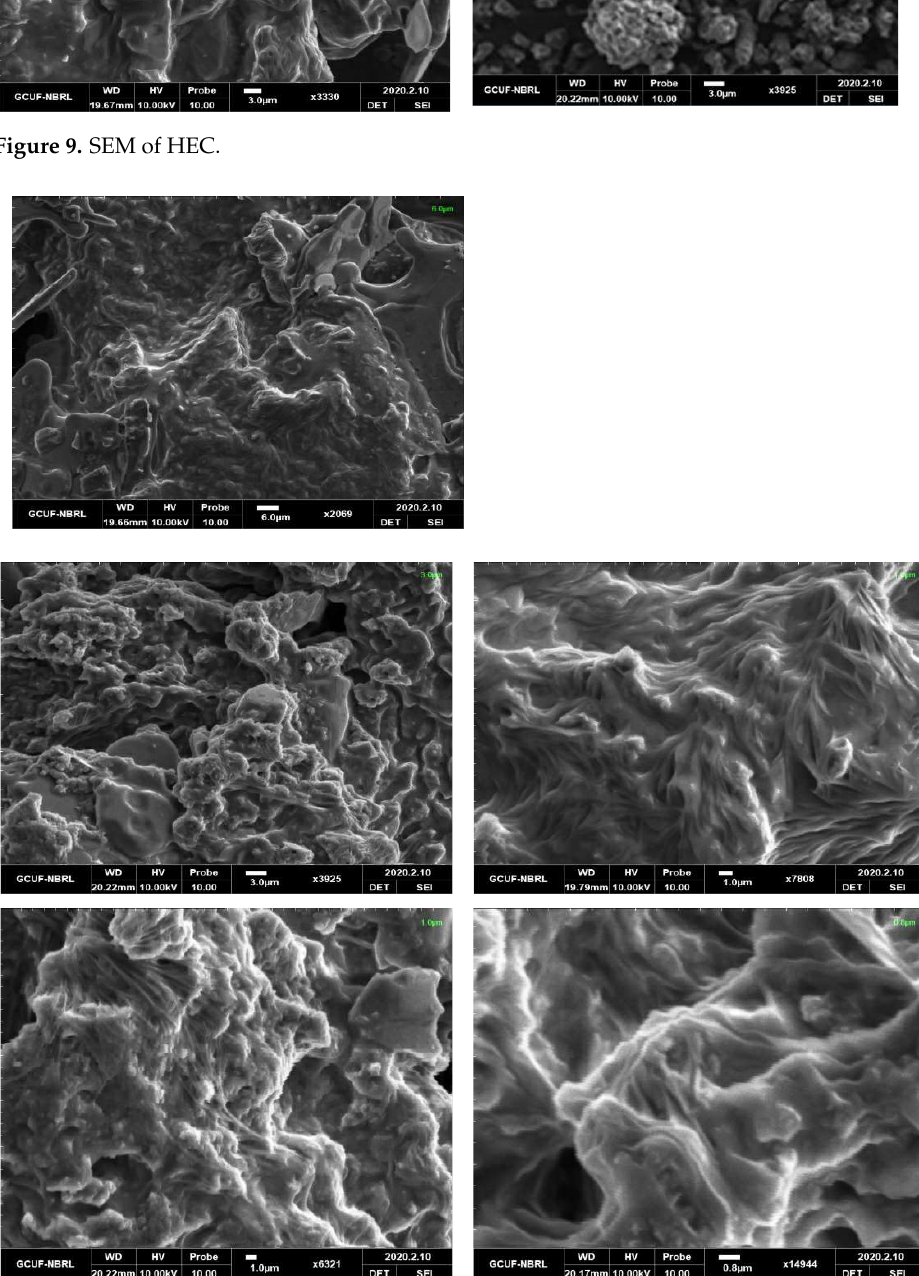
Figure 10. SEM images of HEC/PANI-PPy.